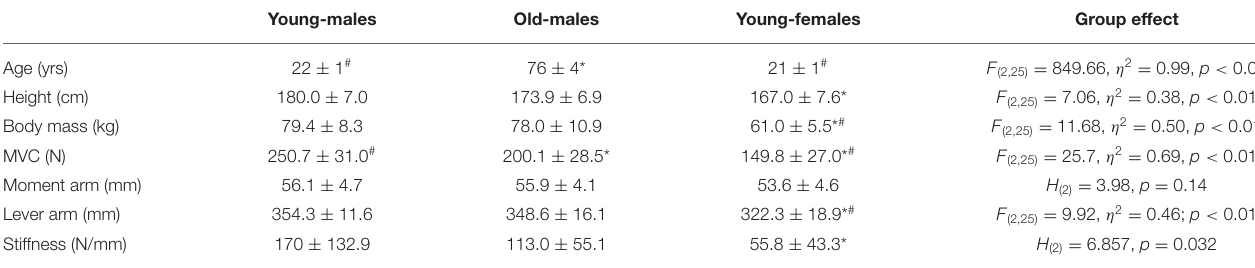
TABLE 1 | Subject